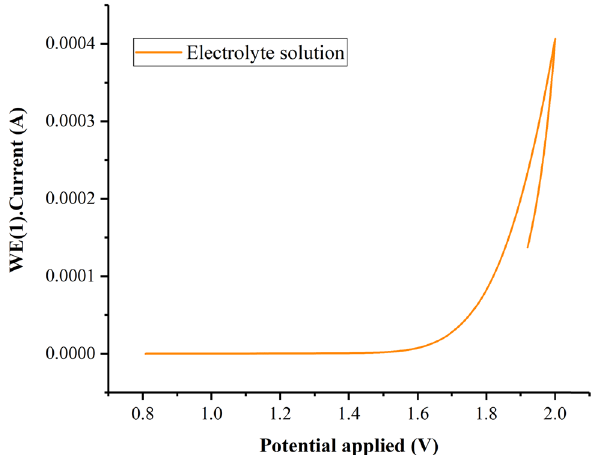
Figure A1: Cyclic voltammetry curve of ITO in an